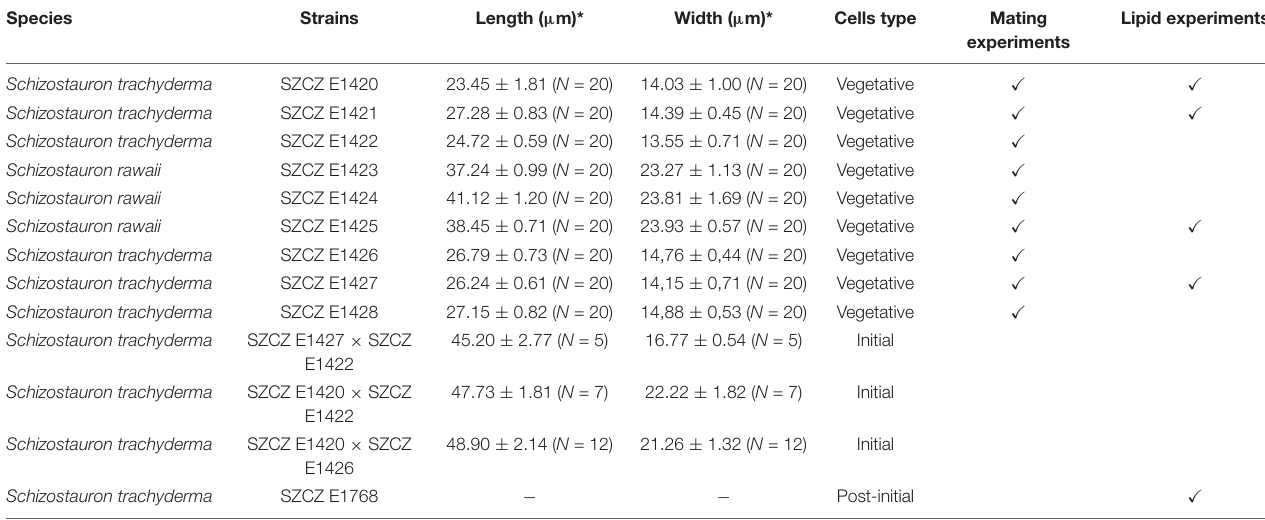
TABLE 1 | List of Schizostauron spp. strains used for mating and lipid experiments. Species Strains Length ( µ m)* Width ( µ m)* Cells